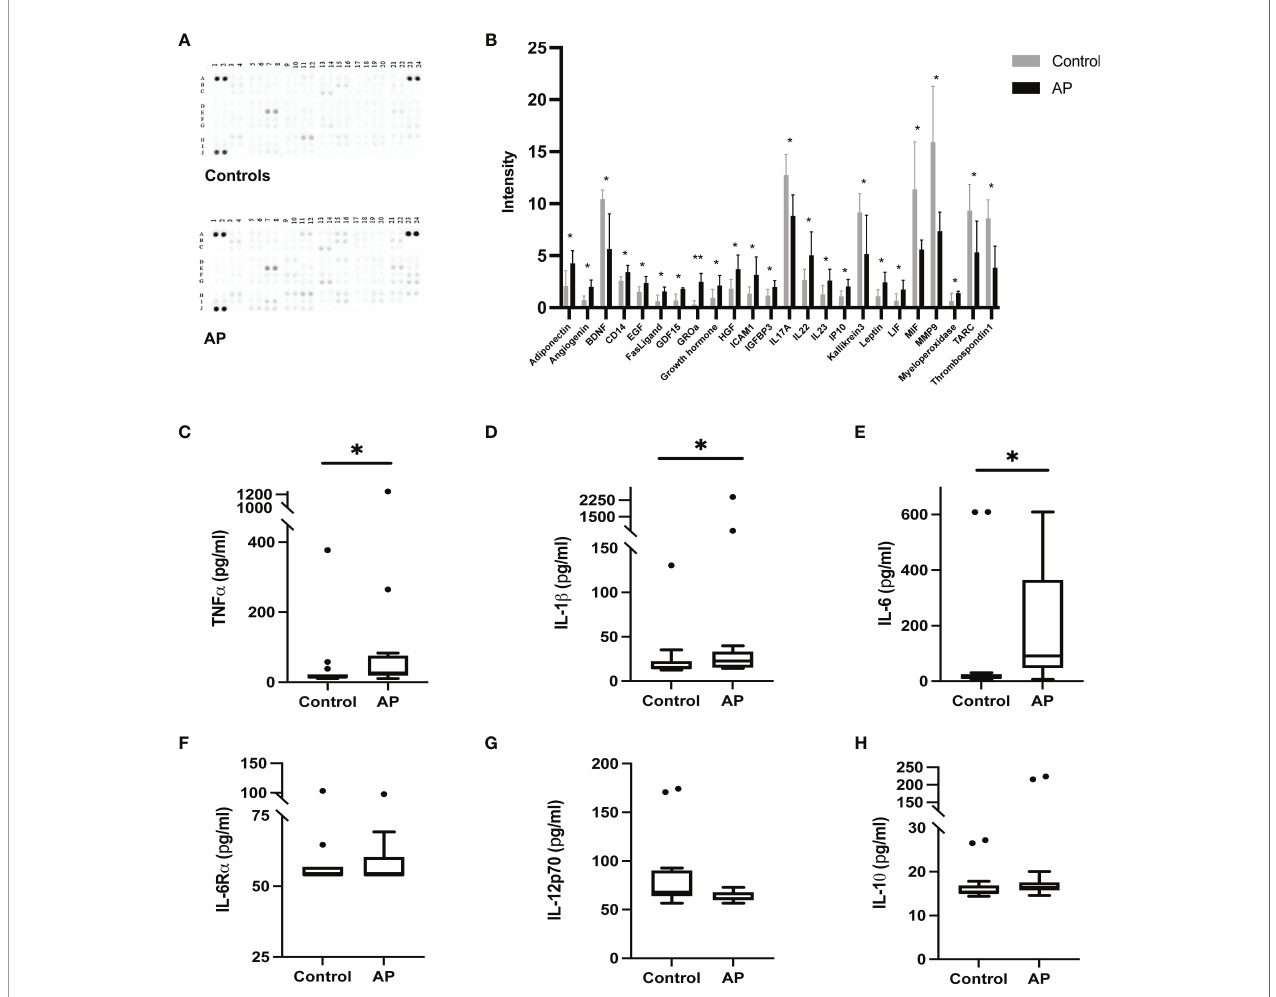
FIGURE 1 | Pro fi ling of secreted in fl ammatory proteins in PBMCs from apical periodontitis and control individuals. (A) In fl ammatory protein pro fi le (B) Relative levels of in fl ammatory proteins. Levels of (C) TNF- a , (D) IL-1 b , (E) IL-6 (F) IL-6R a , (G) IL-12p70 and (H) IL-10 expressed in pg/ml. AP apical periodontitis. *p < 0.05, **p <